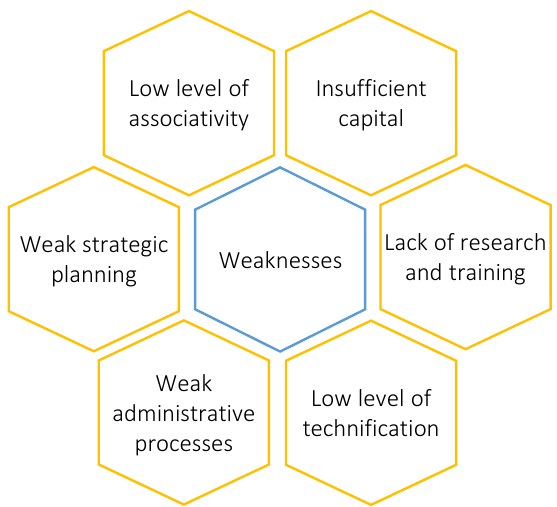
Figure 2. Organizational characteristics of SMEs in the commerce and service sector of the Municipality of Palmira –